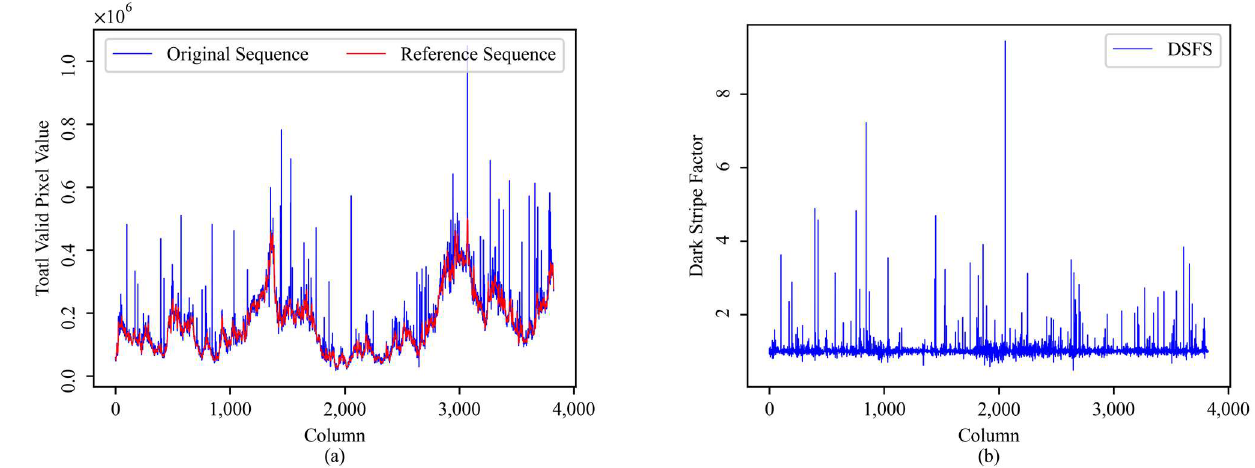
Figure 6. The dark stripe detection of the image shown in Figure 3a. ( a ) The total pixel value sequence; ( b ) the dark stripe factor sequence.